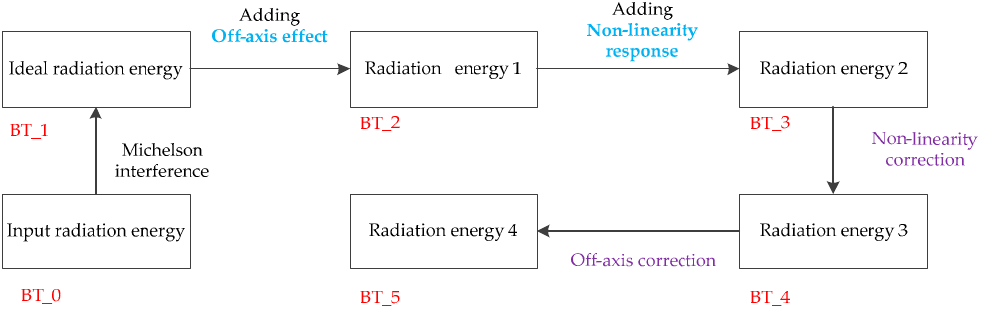
Figure 4. Flow chart of the analysis of o ff -axis e ff ects and the non-linearity response. Figure 4 . Flow chart of the analysis of off-axis effects and the non-linearity response.